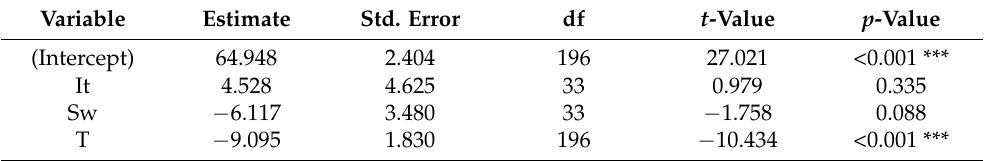
Table 2. Statistical analysis of height increment in 2020. In the model, the Belgian provenance is the standard to which the Italian (It) and Swedish (Sw) provenances are compared, and for the treatment in 2018 (T), the control is the standard to which the water limitation is compared. Variable Estimate Std. Error df t -Value p -Value (Intercept) 64.948 It Sw − 6.117 T <0.001 *** *** p <